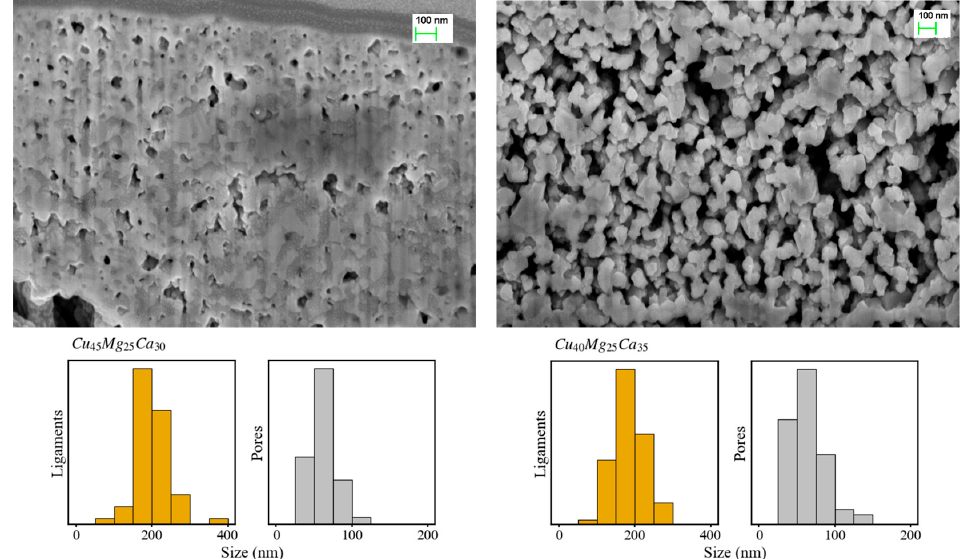
Figure 7. Images of the nanoporous copper structure formed near the surface of Cu45 ( left ) and Cu40 ( right ) samples. The corresponding size distributions of ligaments (orange) and ligaments (grey) are shown below.